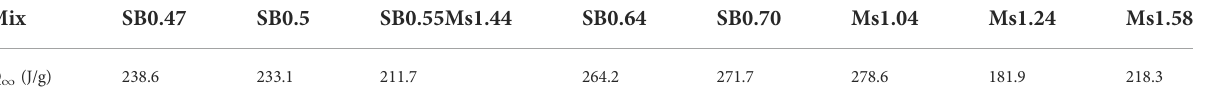
TABLE 3 Extrapolated ultimate heats Q ∞ for the different